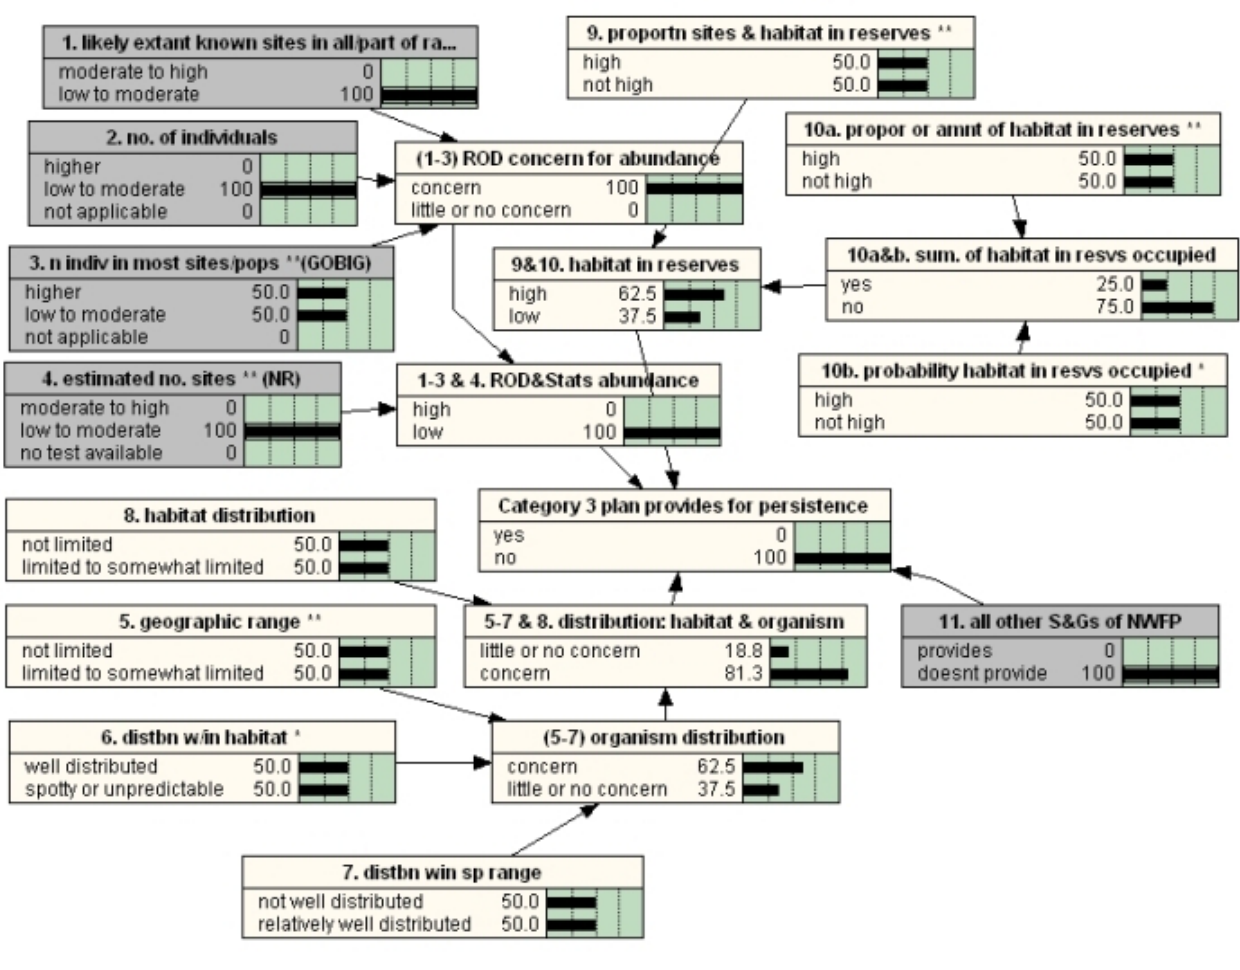
Fig. 4. Bayesian belief network (BBN) submodel for determining evaluation category 3, whether the Northwest Forest Plan provides for persistence of the species. See Table 2 for Record of Decision guidelines used to develop this model. GOBIG is a species occurrence database from